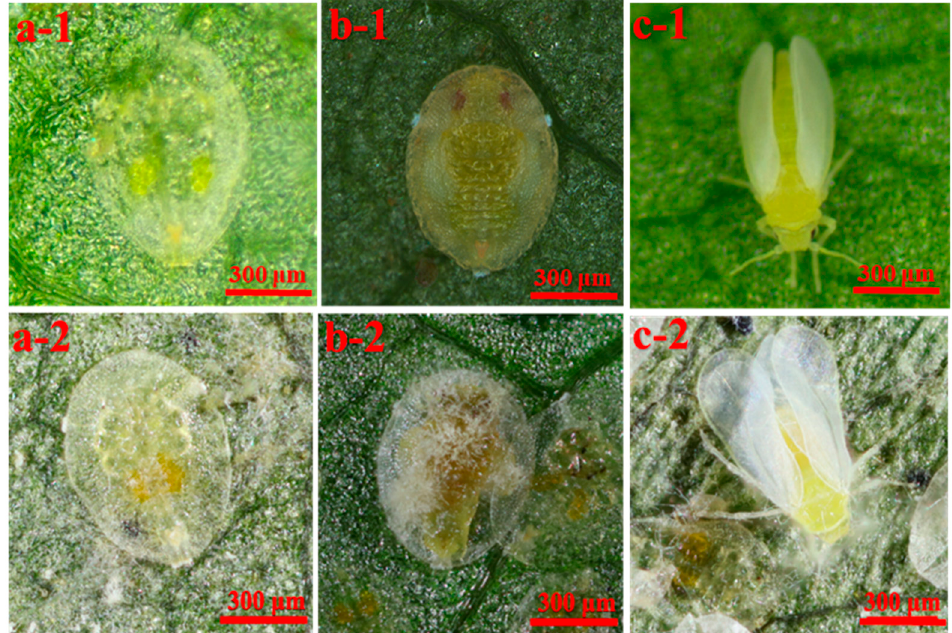
Figure 3. The infection phenotype of Bemisia tabaci MEAM1 nymphs treated with Akanthomyces attenuatus (1 × 10 8 conidia/mL). Panels ( a-1 ) and ( a-2 ) were healthy 3rd nymphs and the fungus-infected 3rd nymphs, ( b-1 ) and ( b-2 ) were healthy 2d age pupae and the fungus-infected 2d age pupae, ( c-1 ) and ( c-2 ) were healthy newly emerged adults and the fungus-infected newly emerged adults of Rickettsia negative B . tabaci on the 5th day after infection.